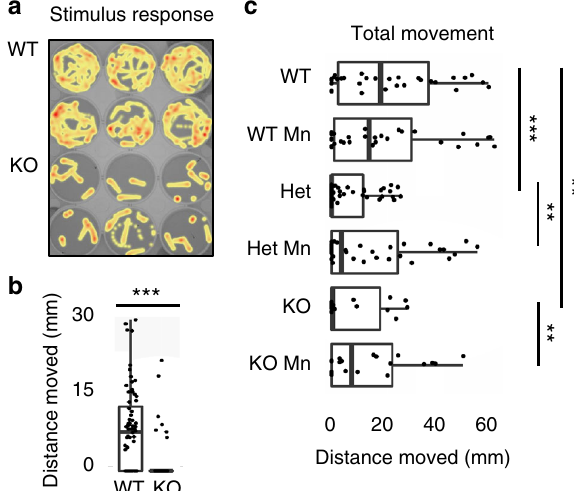
Fig. 5 Movement de fi cits in zebra fi sh slc39a8 − / − larvae. Zebra fi